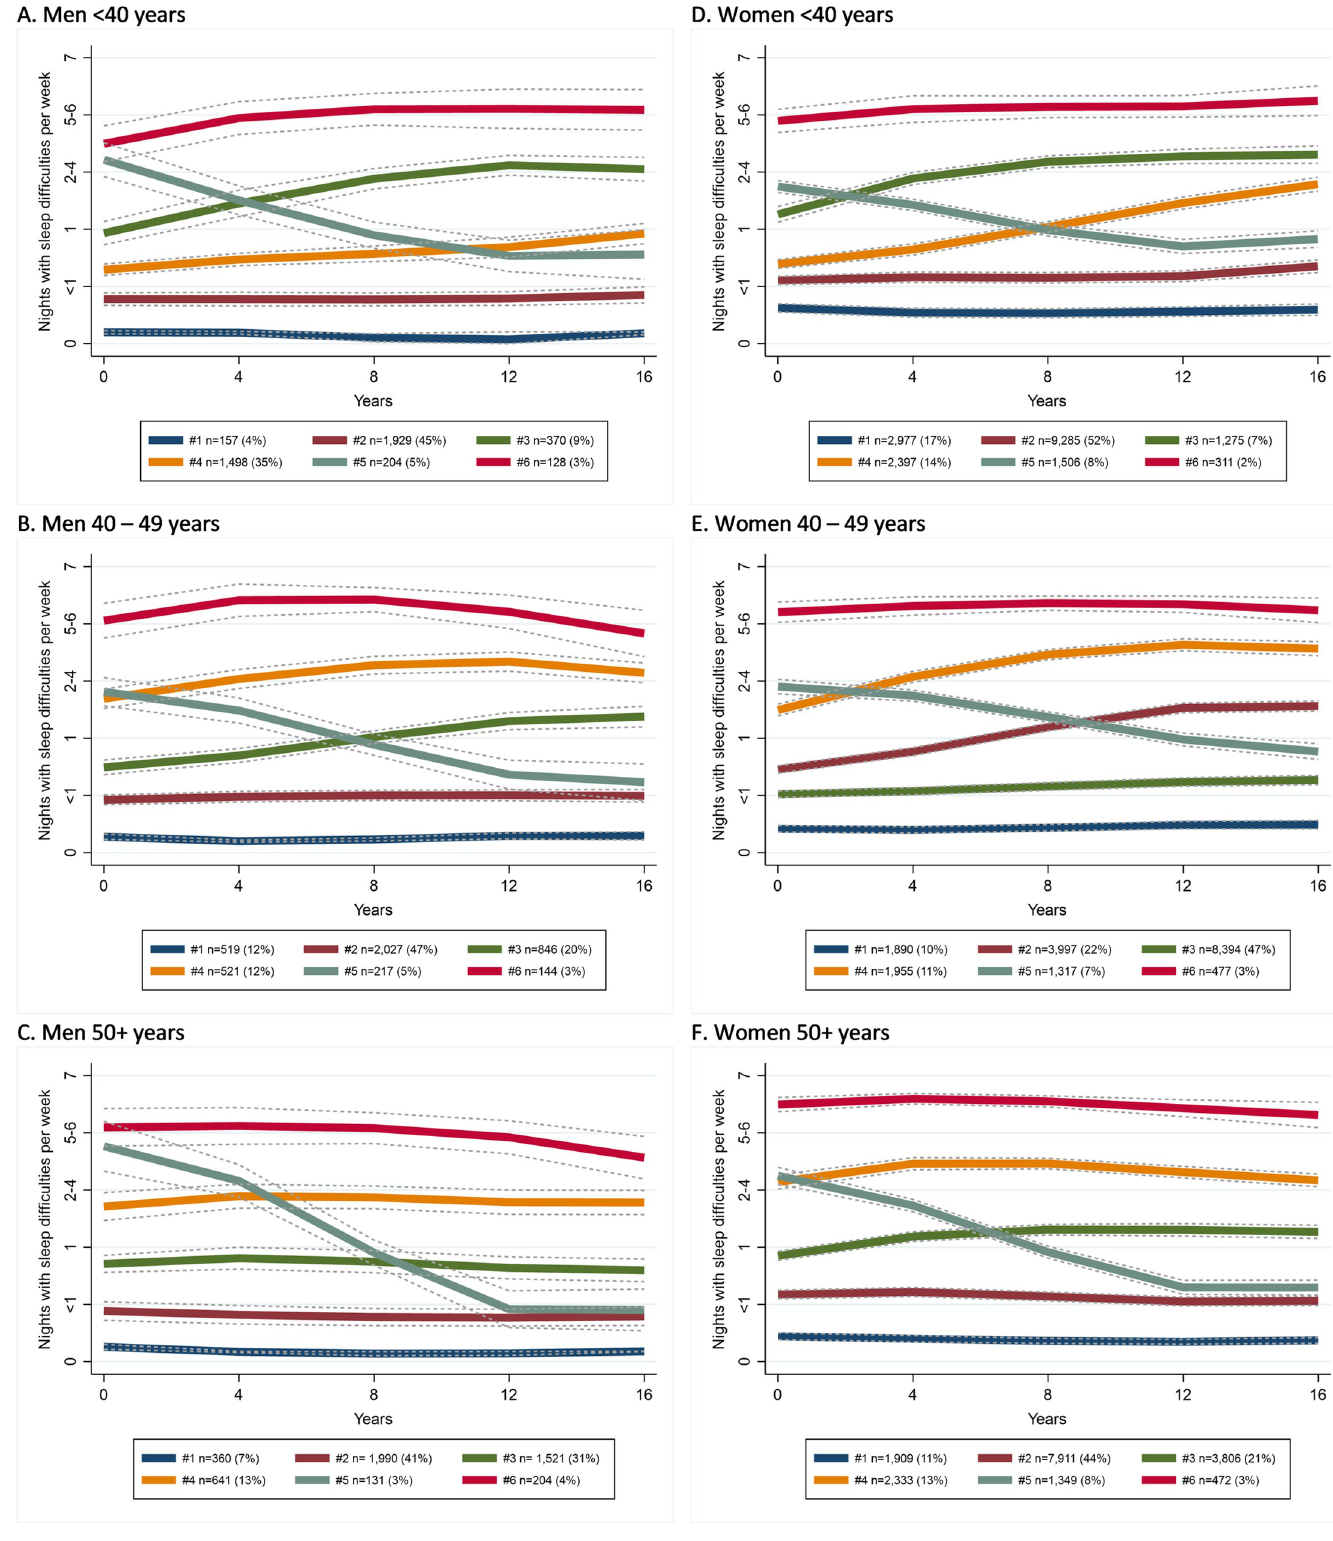
Fig 1. Trajectories of the JSS by gender-age groups.